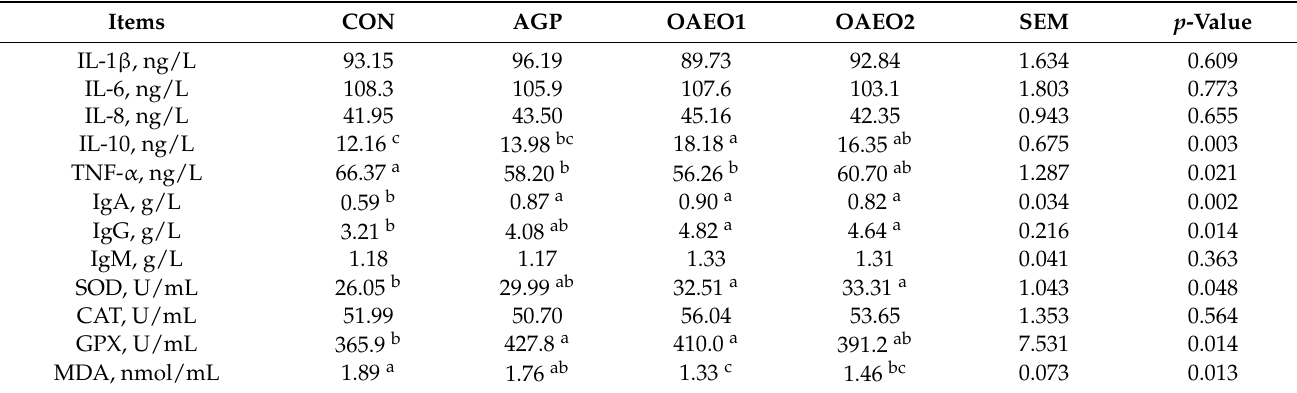
Table 2. Effect of OAEO on serum immunity and antioxidation function of weaned